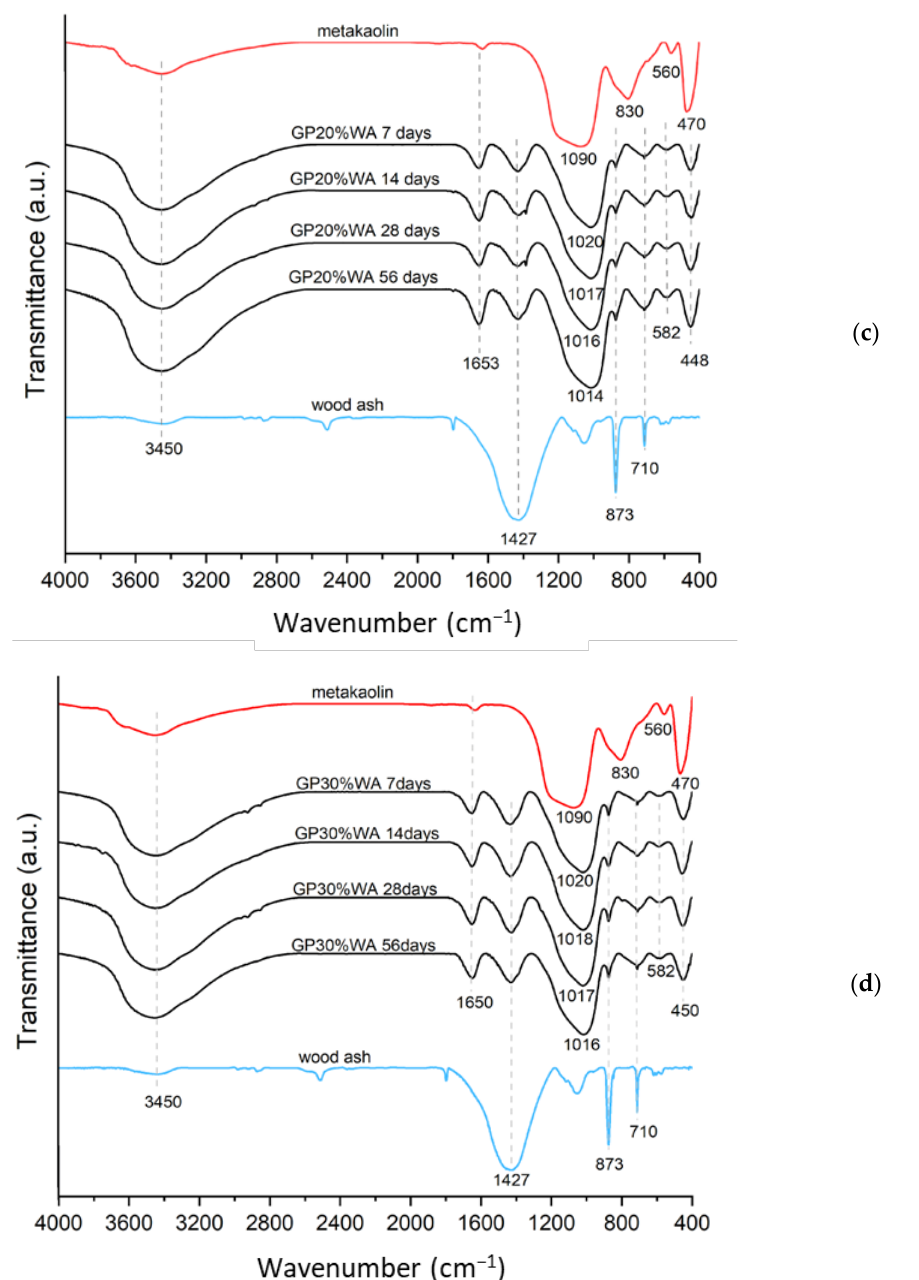
Figure 5. FT-IR spectra of samples during the time: ( a ) (GP); ( b ) (GP10%WA); ( c ) (GP20%WA); ( d ) (GP30%WA).